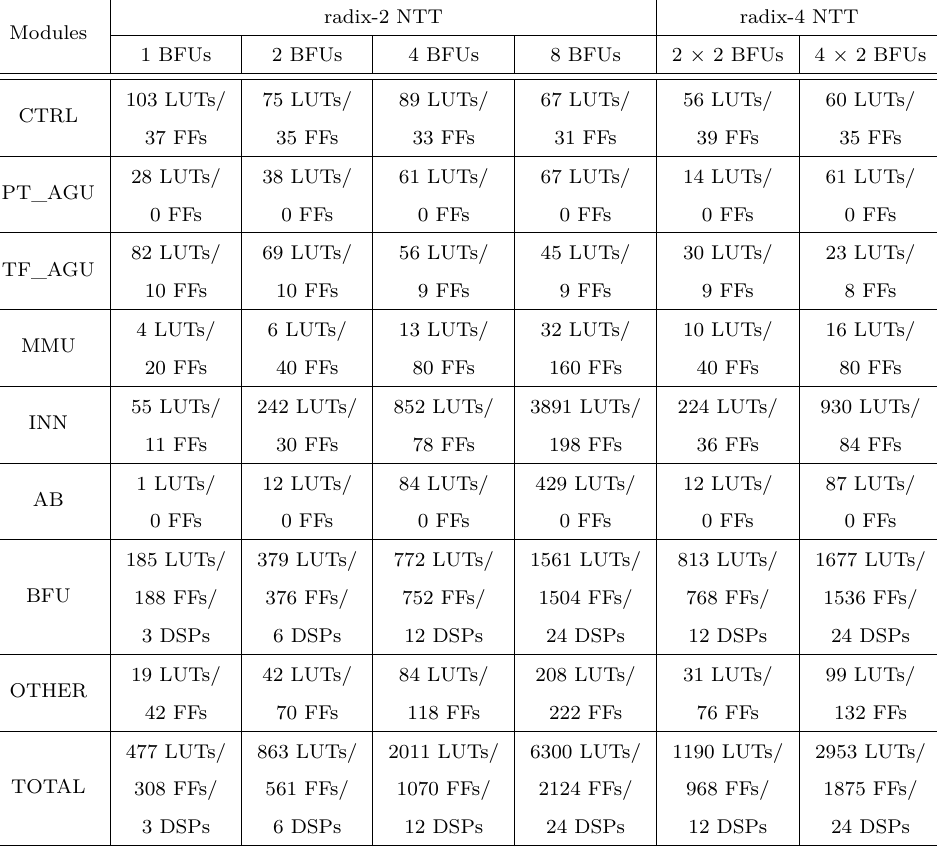
Table 4: The resource usage broken down across different modules in radix-2 and